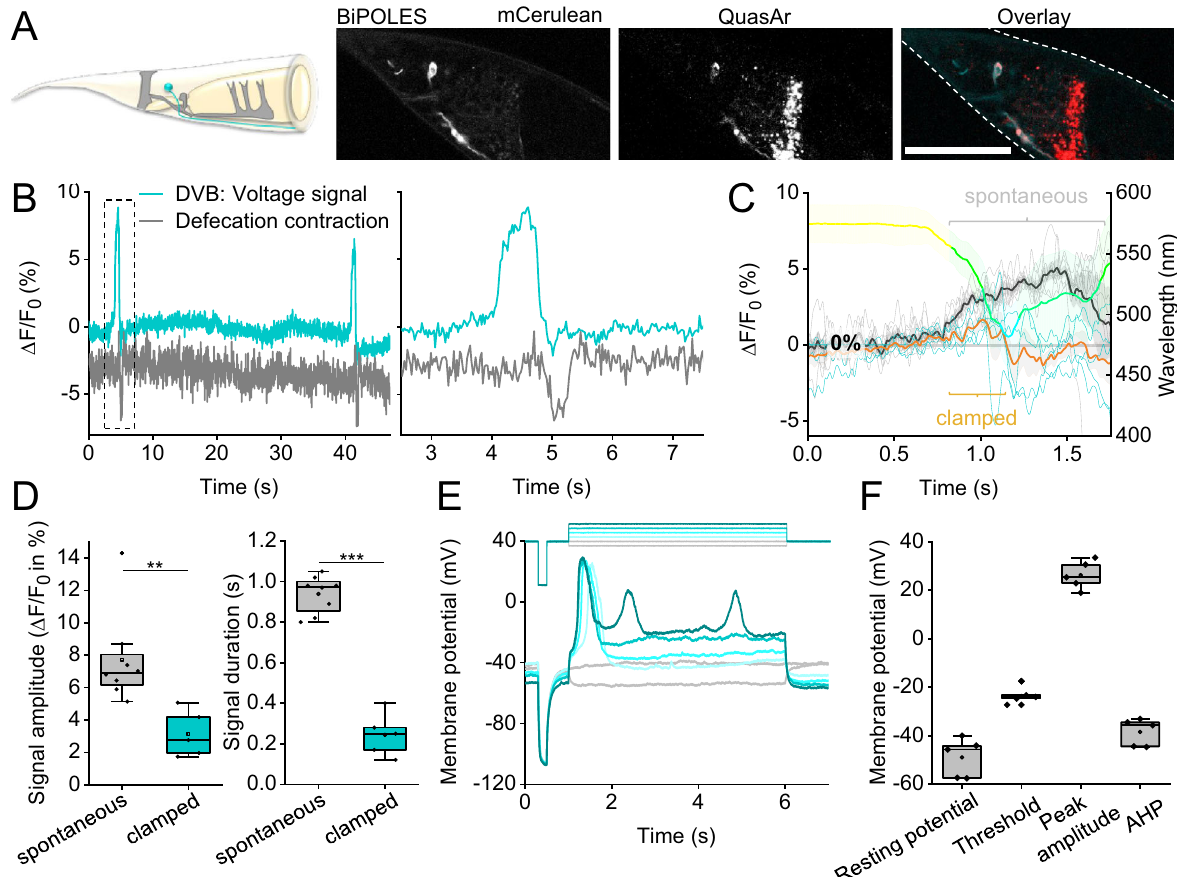
Fig. 7 | All-optical clamping of APs in the enteric motor neuron DVB. A GABAergic motor neuron DVB (cyan), innervating enteric muscles (gray, upper panel). Below: confocal z -projection, BiPOLES and QuasAr2 in DVB, and overlay; scale bar: 50 µ m. B Voltage fl uorescence signals, spontaneous APs in DVB (blue trace). Expulsion muscle contraction, deduced from DVB movement (gray trace). Rightpanel:Close-upofboxedregion. C Overlayof spontaneous(lightgraytraces, n =8; mean: black) and clamped (blue traces, n =5; mean: orange) DVB voltage signals.MeanwavelengthsetbyOVCshowninrespectivecolor. D Statisticsofdata in C , mean voltage fl uorescence signal amplitude and total duration (amplitude